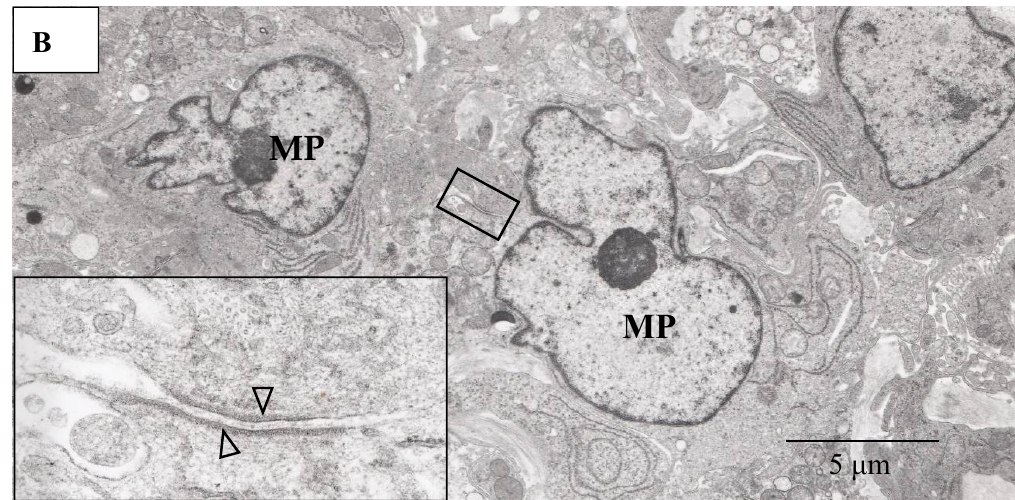
Figure 12. ( A – C ) Light microscopy photograph of granuloma (Gr) adjacent to the retinal artery ( A ) located in the area of radial peripapillary capillaries, and transmission electron microscopy photographs ( B , C ) in the left eye of Autopsy Case 1, 75-year-old female. B and C are ultrathin sections of granuloma (Gr) and boxed area in ( A ), respectively. Epon embedding, toluidine blue stain. Granulomas were composed of macrophages (MP in B ) and had subplasmalemmal linear density (arrowheads in B , inset). The inset in ( B ) is a high magnification of the boxed area in B . The arterial wall became thick because of basal lamina layering (stars in C ). Lymphocytes (Ly in C ) were observed under the endothelium of the artery.